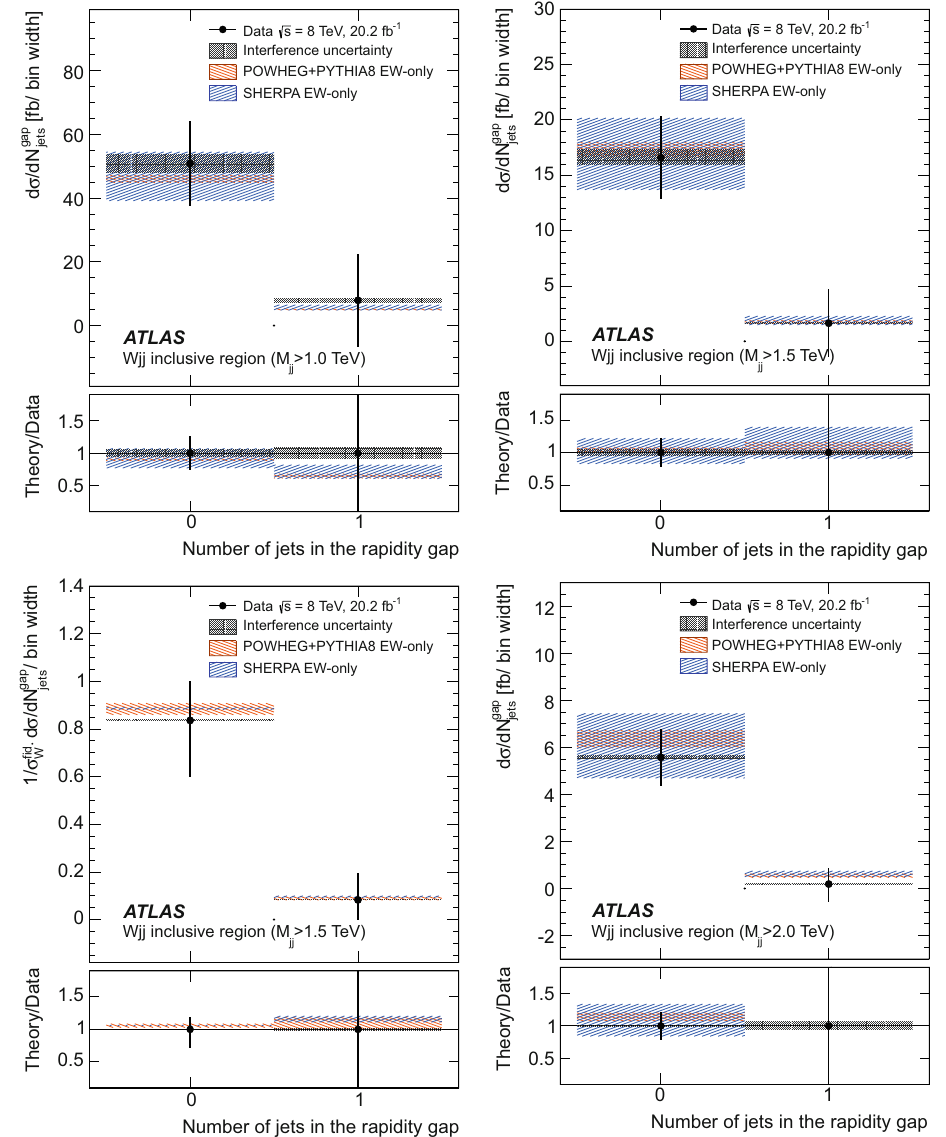
Fig. 36 Differential electroweak W jj production cross sections as a function of the number of hard jets in the rapidity gap between the two leading jets in the inclusive fiducial region with M jj > 1 . 0 TeV ( top left ), 1.5 TeV ( top right and bottom left ), and 2.0 TeV( bottom right ). The region with M jj > 1 . 5 TeV, includes both absolute ( top right )